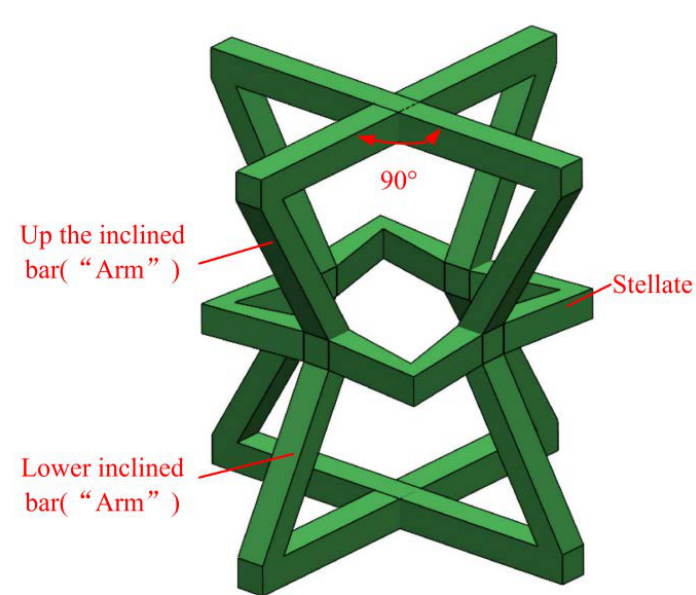
Figure 2. Schematic diagram of structural single cells.